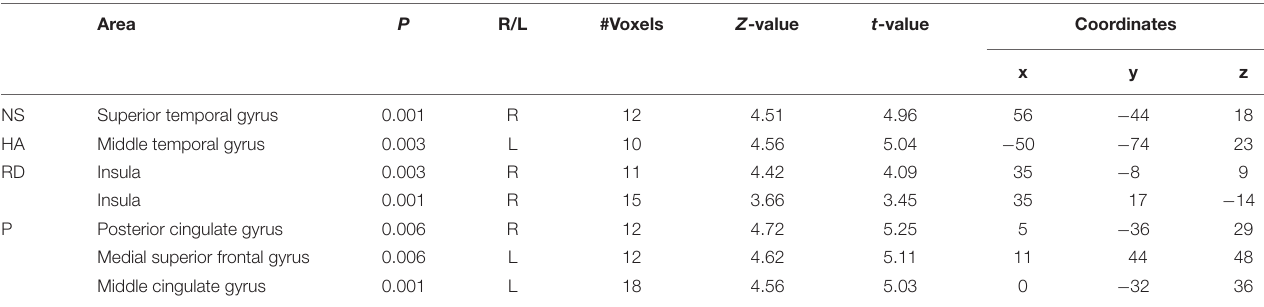
FIGURE 1 | Mean score of the four temperament scores [novelty seeking (NS), harm avoidance (HA), reward dependence (RD), and persistence (P)] and each subscale (NS1, NS2, NS3, NS4, HA1, HA2, HA3, HA4, RD1, RD2, RD3, and P) for males and females separately. Error bars represent standard error of the total score (NS, HA, RD, and P). The results show a significant higher score on NS and RD for females, driven by NS2, NS3, RD1, and RD2. ∗ Marks significance at p < 0.05. TABLE 1 | Sex-temperament interaction effects in voxel-wise